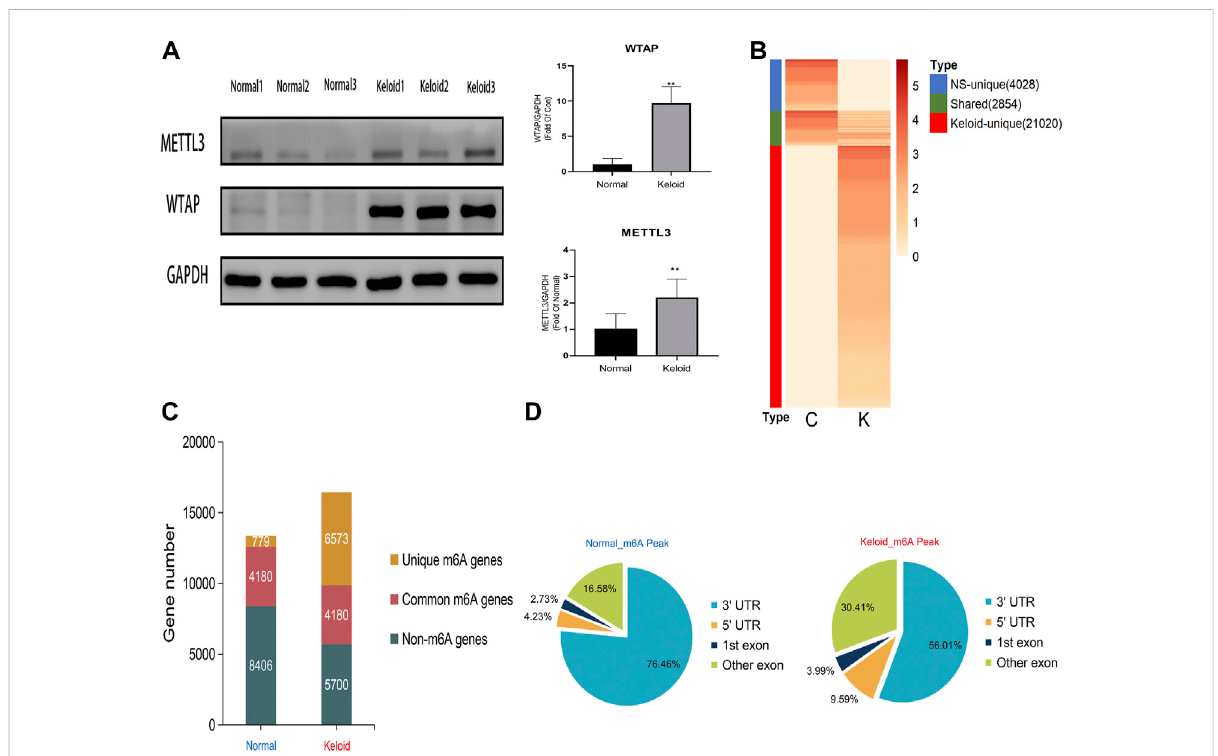
FIGURE 1 Transcriptome wide of MERIP-seq and the distribution of m 6 A peaks in the keloid tissue and in the normal skin tissue. (A) Protein level of the METTL3 and WTAP methyltransferases in two types of tissues. n = 3 samples were randomly selected from each group in the WB experiments, * p < 0.05. (B) Signal heatmaps of unique and shared m 6 A peaks between the keloid and normal skin. The signal was presented with the value of log2 fold change of the distinct m 6 A peak sets. (C) Summary of m 6 A-modi fi ed genes identi fi ed in both groups. (D) Distribution of m 6 A peaks in the genic regions of the two